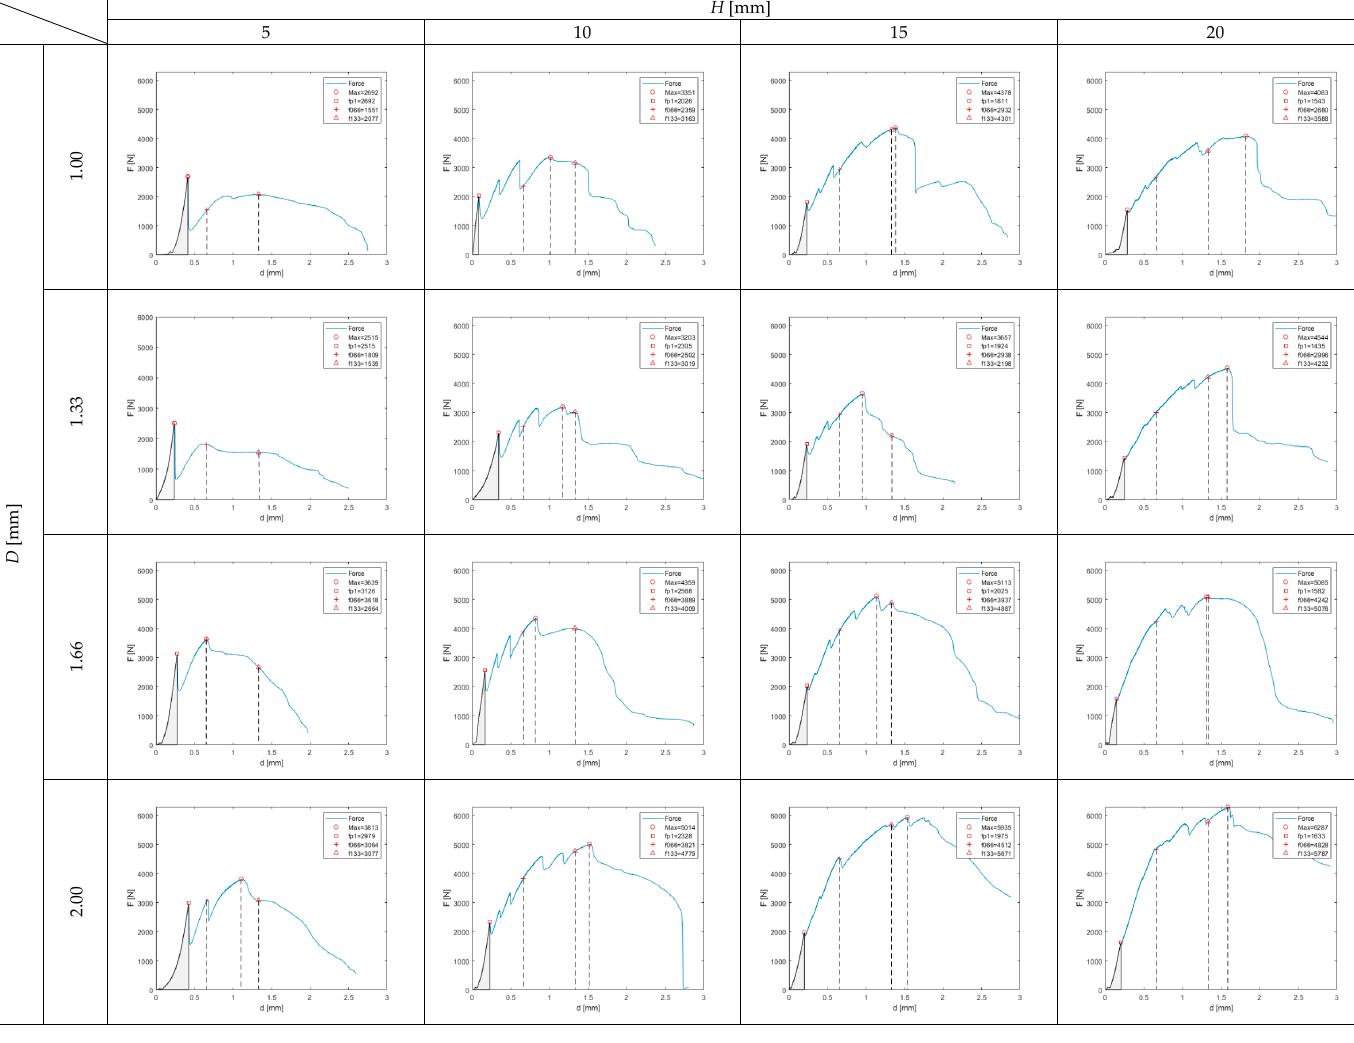
Figure 6. Load ( F )–deflection ( d ) relations for tested prism specimens with marked four characteristic points (values of load achieved for each key point are listed